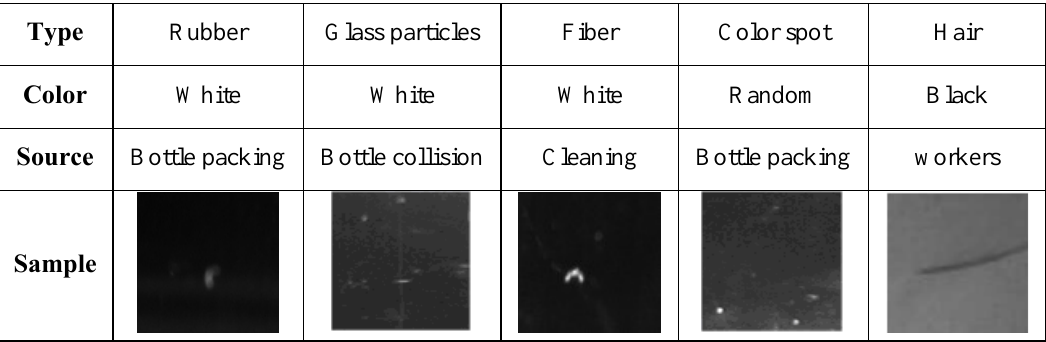
Table 1. Foreign substance